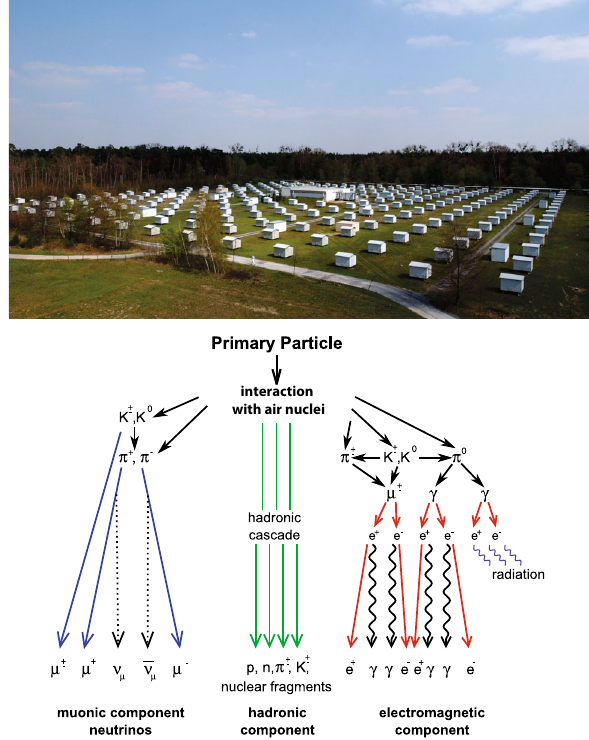
Fig. 2 Photograph of the KASCADE array with its central detector building (upper panel); Schematic view of an extensive air shower (EAS), where KASCADE is measuring the hadron, muon, and elec- tron components (lower